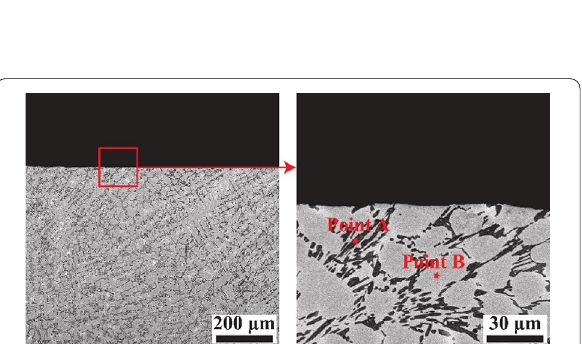
Figure 5 Microstructure of Co-based alloy surfacing